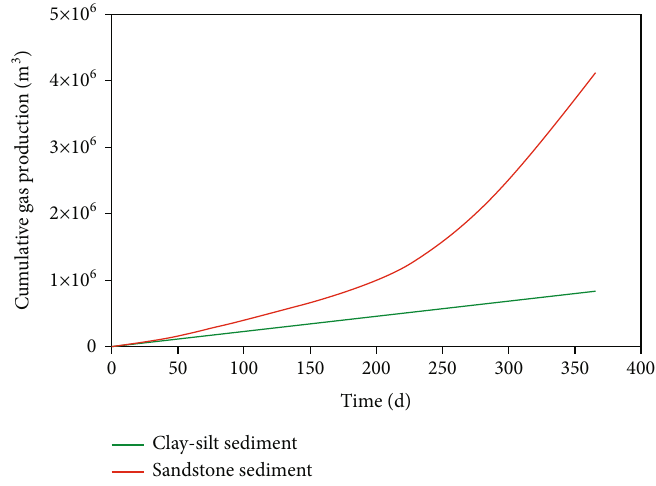
Figure 20: The comparison of cumulative gas production.